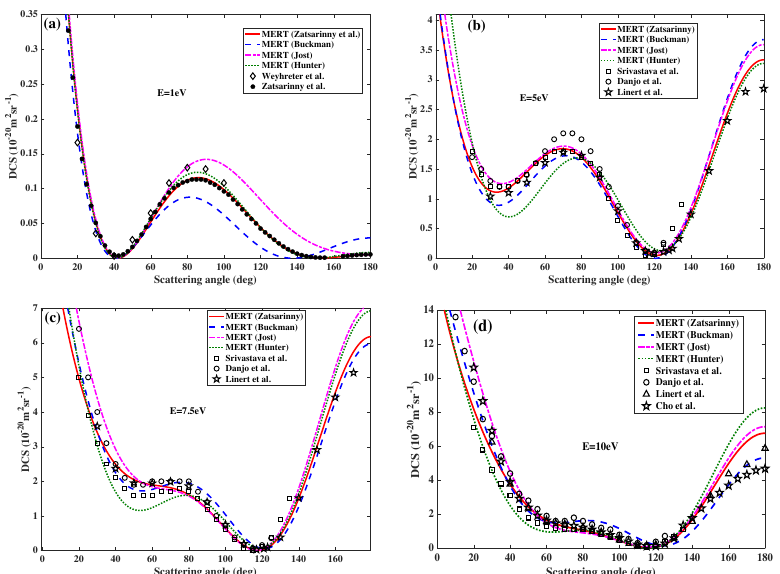
Figure 6. Angular dependencies of MERT − derived differential cross − sections at ( a ) 1, ( b ) 5, ( c ) 7.5, and ( d ) 10 eV for e − − Kr scattering. The present results are compared with experimental data of Srivastava et al. [57], Danjo [69], Linert et al. [70], Cho et al. [71], Weyhreter et al. [55], and Zatsarinny et al. [68].